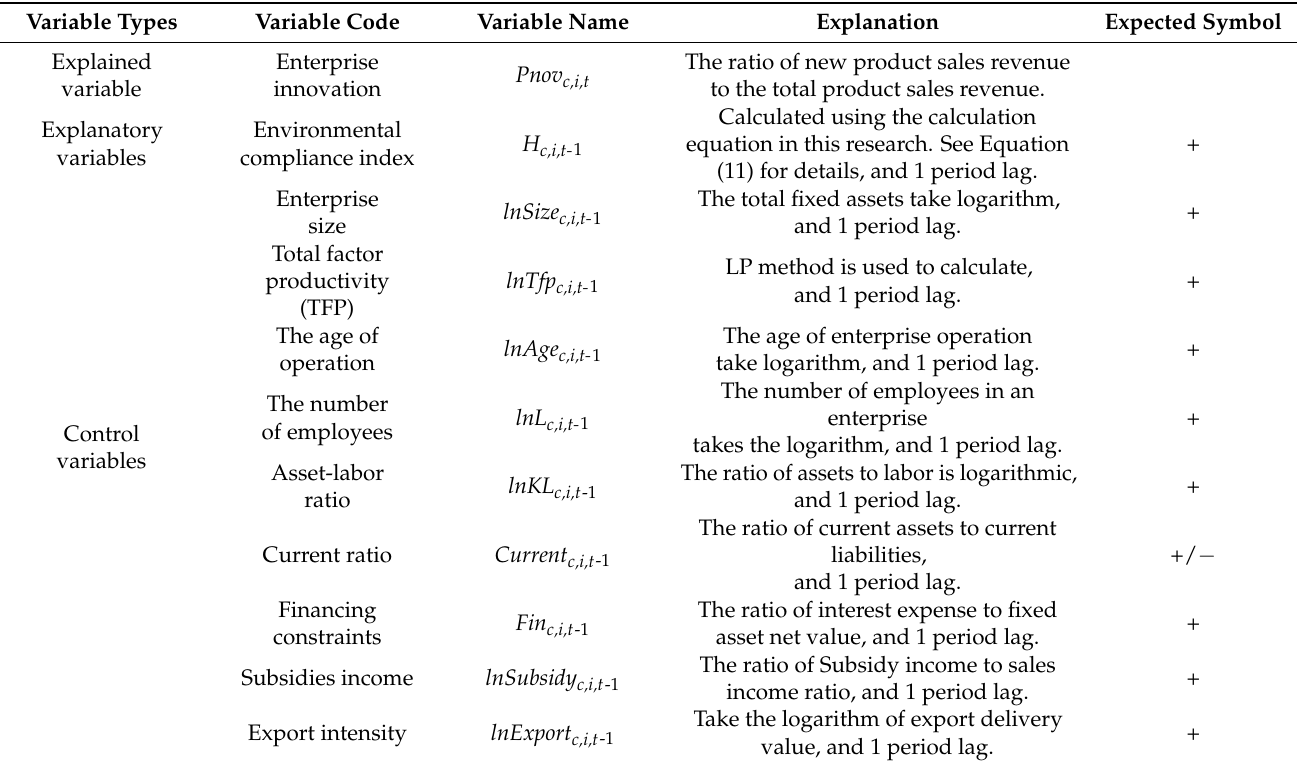
Table 1. Usage description of main